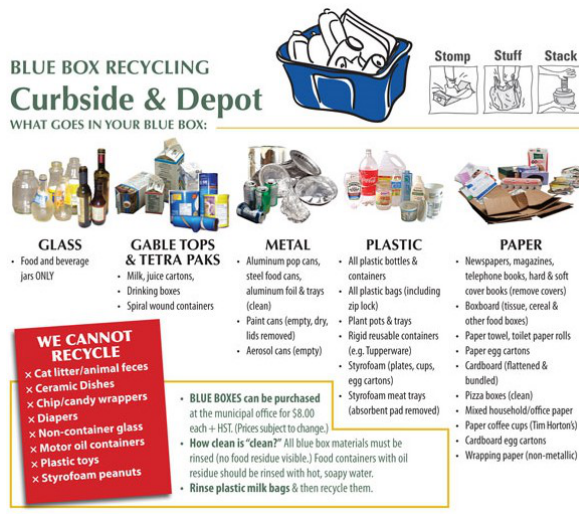
Figure 3. Sample Newspaper Advertisement # 2.